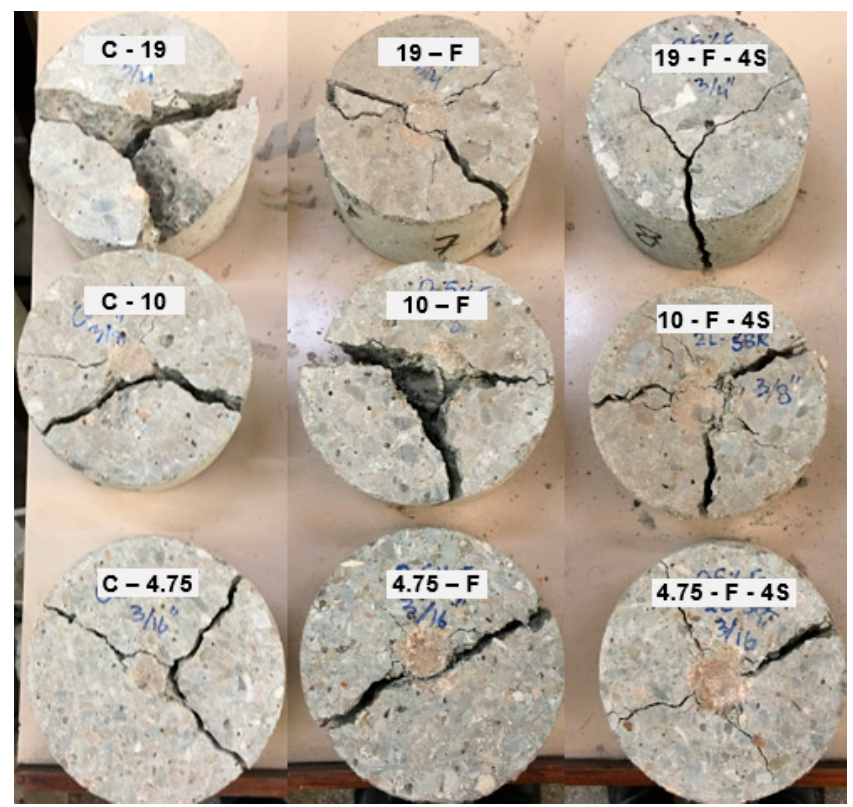
Figure 14. Failure pattern of disc sample (Y-shape).